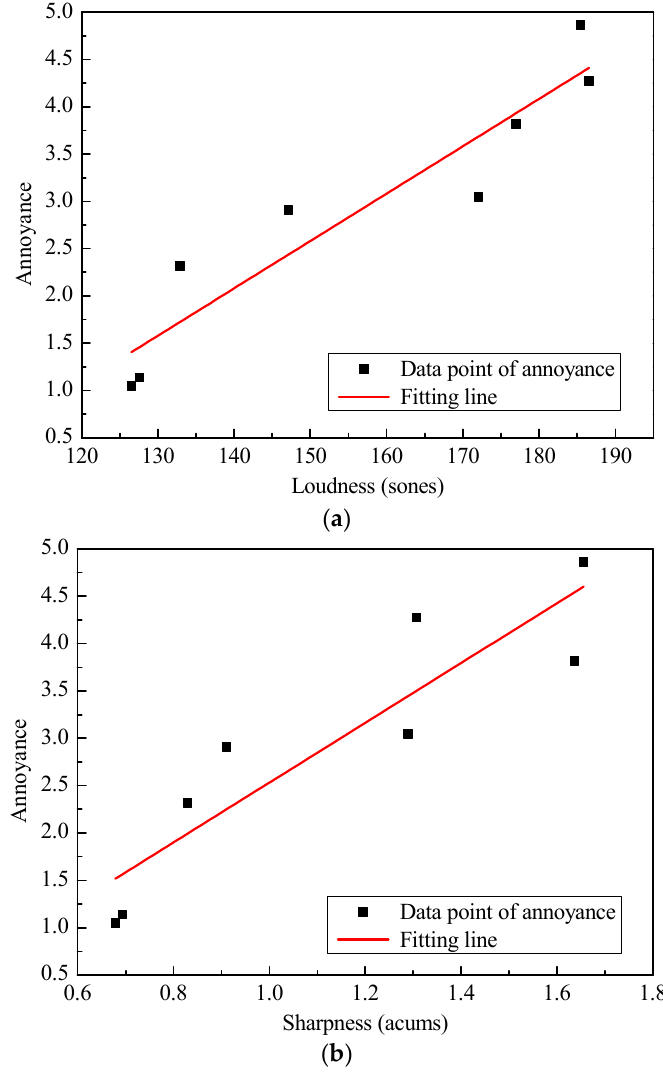
Figure 19. Analysis results of regression between SQ metrics and annoyance. ( a ) Correlation between loudness and annoyance. ( b ) Correlation between sharpness and annoyance.